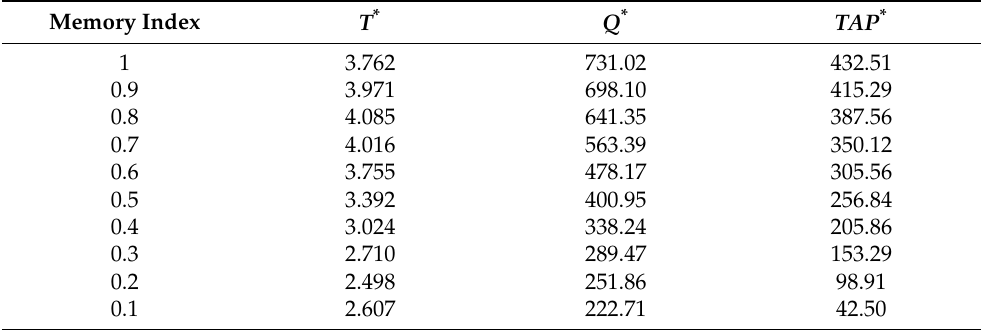
Table 5. Impact memory on optimum values of the objective function total average profit ( TAP ∗ ), and decision variables, namely,lot size ( Q ), total lot cycle ( T ) for the model without shortage. Memory Index